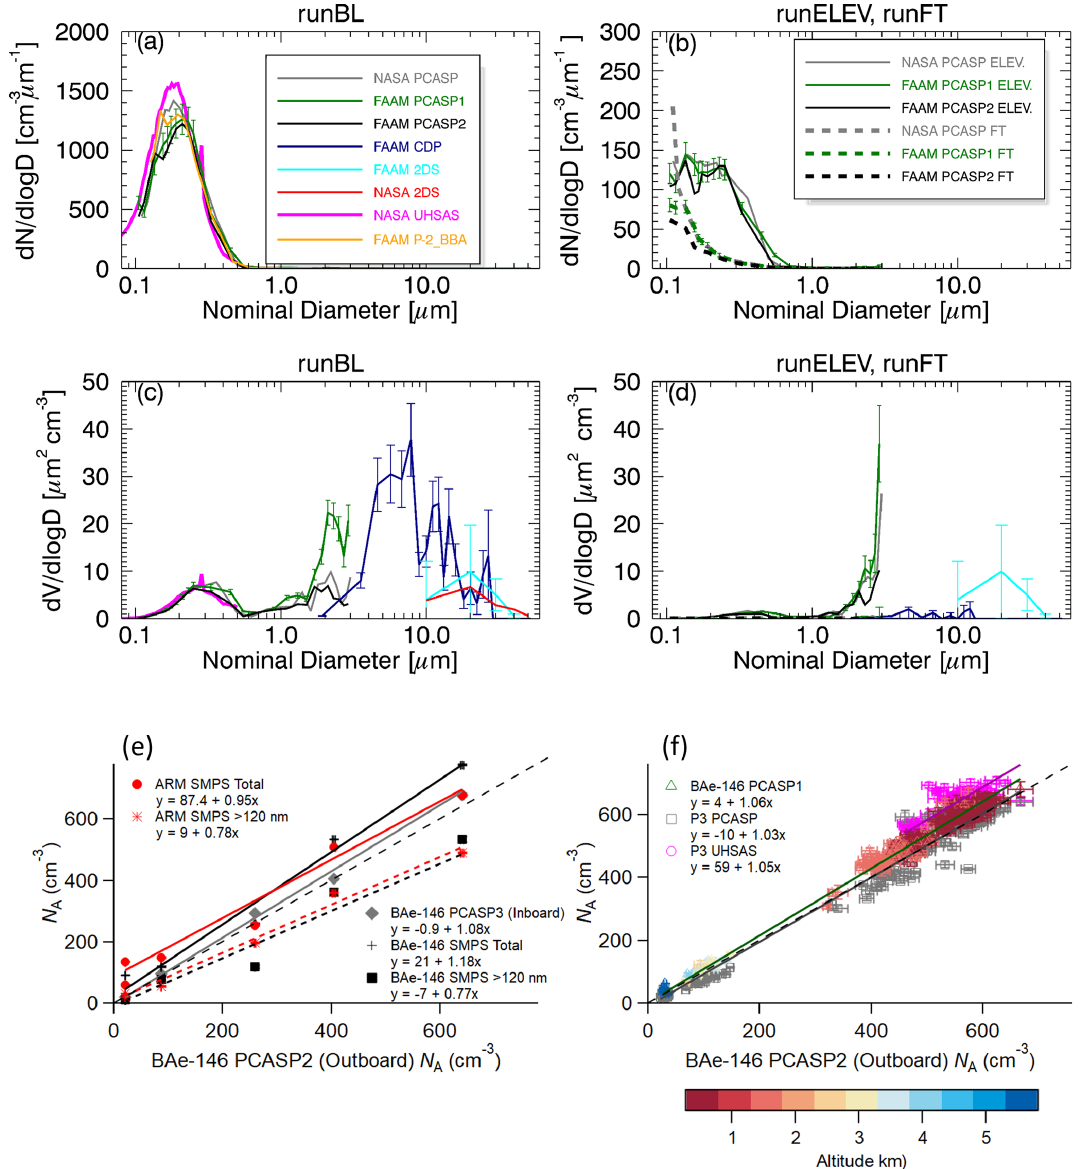
Figure 7. Aerosol particle size distribution for (a) runBL, (b) runELEV (solid lines) and runFT (dashed lines) and volume size distribution for (c) runBL, (d) runELEV (solid lines) and runFT (dashed lines). Errors (positive only) are only shown for FAAM PCASP1, FAAM CDP and FAAM 2DS to aid clarity; see main text for details. The legend in panel (a) applies to panels (a) , (c) and (d) . Correlations from various flight segments (Table 2) between aerosol number concentration measurements are shown for between FAAM BAe-146 PCASP2 for (e) ground–airborne comparisons, where dashed lines refer to LASIC SMPS data restricted to particles with diameter larger than 120nm, and solid lines refer to all sizes of particles and (f) airborne comparisons, where sample altitude is given by the colour bar for the FAAM PCASP2 and FAAM PCASP1 comparisons and a single colour for other probes to aid